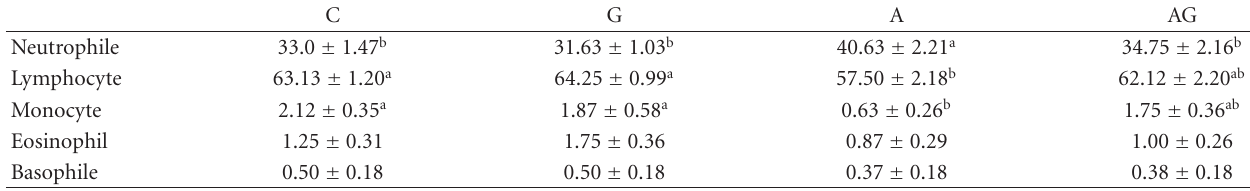
Table 3: E ff ects of AF and glucomannan on di ff erential leukocyte counts ( n = 8, X ± SX). C